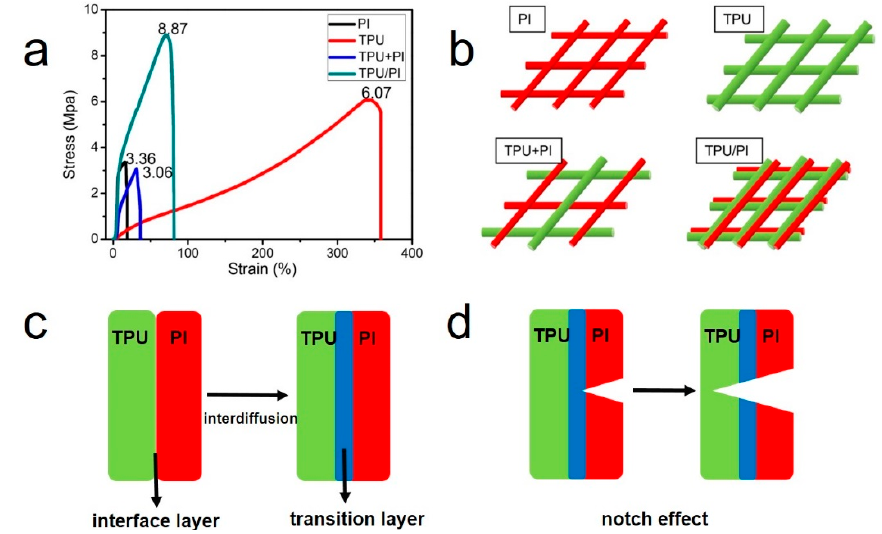
Figure 3. ( a ) fiber stress-strain test curve: TPU, PI, TPU+PI and TPU/PI polymer electrolyte. ( b ) Structure diagram of the fiber membranes. ( c ) Formation diagram of the interface transition layers. ( d ) Schematic diagram of the “notch affect”.